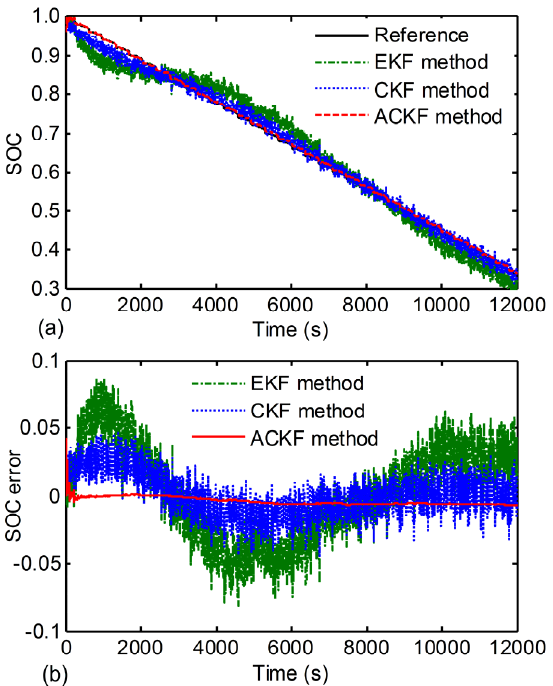
Figure 12. SOC estimation results with voltage noise under DST test: ( a ) SOC; ( b ) SOC error.